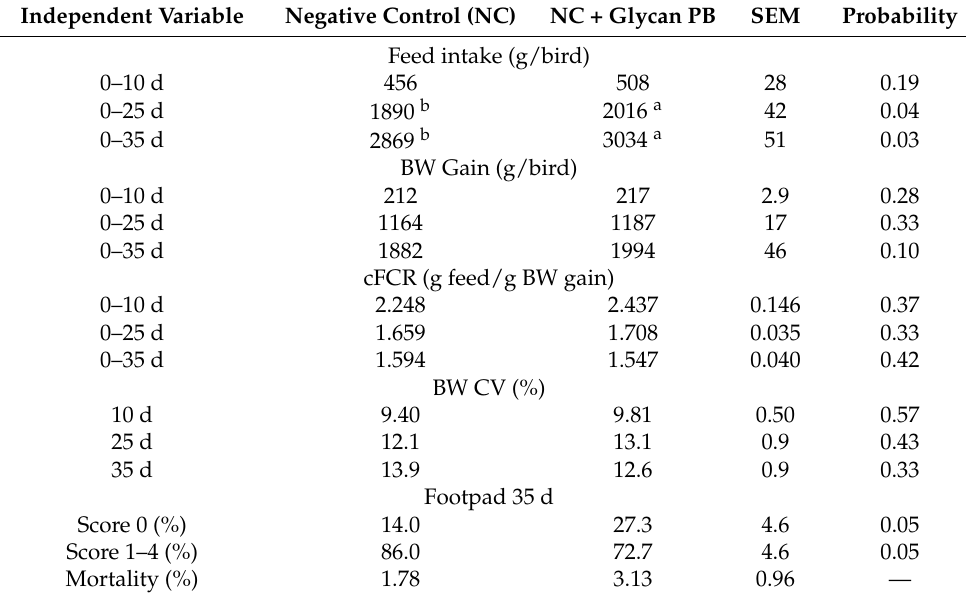
Table 5. Effects of a precision biotic (Glycan PB) ingredient 1 supplemented at 500 g/MT in feed on the growth performance, BW variability, foot pad lesion scores, and mortality of broiler chickens raised in floor cages within a commercial broiler house (Trial